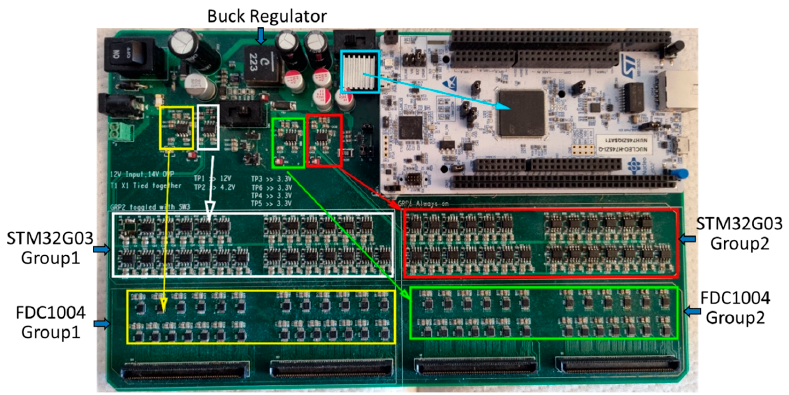
Figure 4. The LDO regulators powering the Motherboard’s sections. The 5 V LDO (teal) powers the MCU section; 3.3 V LDO 1 and 2 (yellow and white) power the Sensor section’s FDC1004 and STM32G03 Group 1s; 3.3 V LDO 3 and 4 (green and red) power the Sensor section’s FDC1004 and STM32G03 Group 2s.